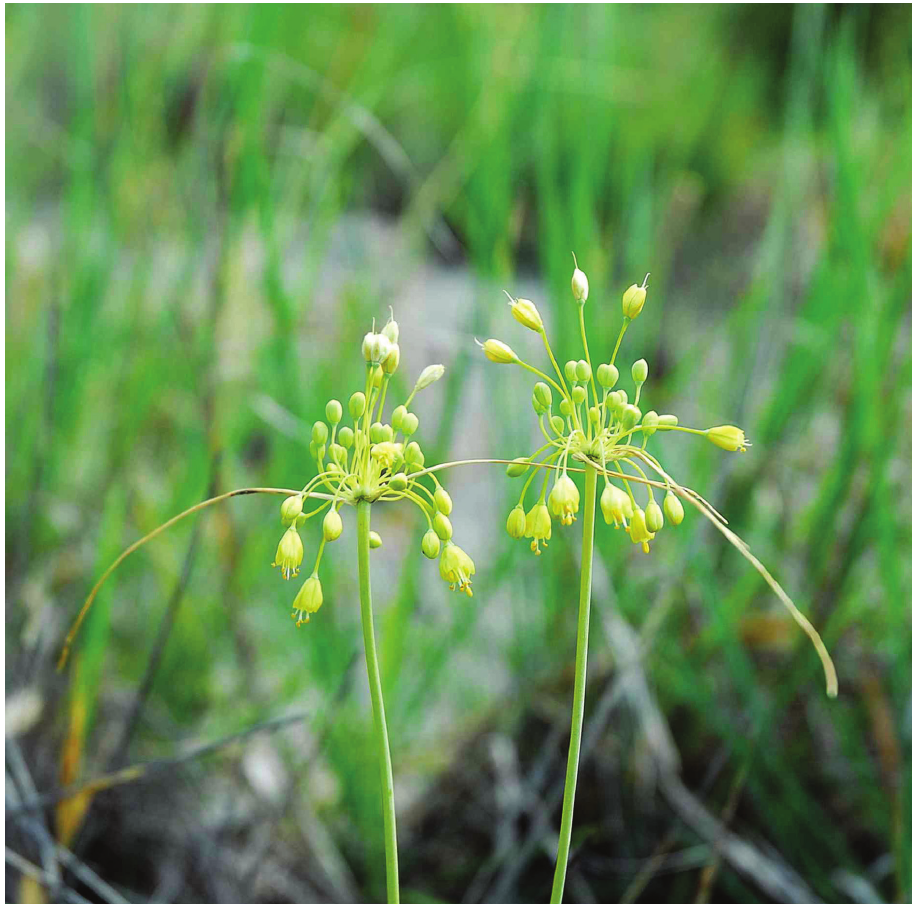
Figure 3. Allium garganicum Brullo, Pavone, Salmeri & Terrasi at a site NNW of Manfredonia (Apulia). Photograph by E.V.